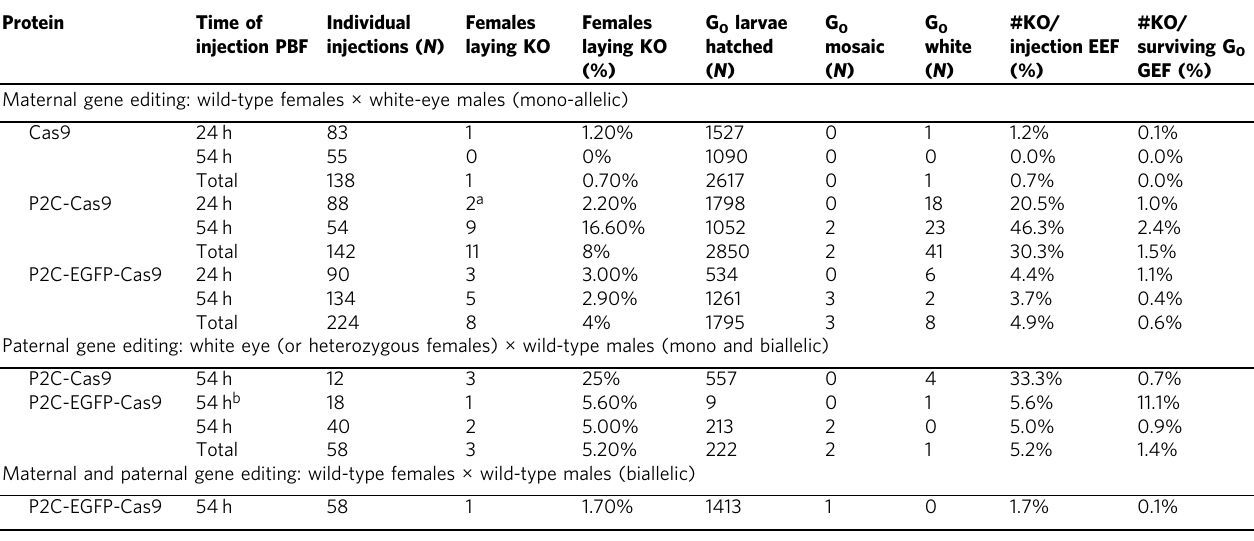
Table 1 ReMOT Control gene editing using optimized concentrations for EER and the RNPs Cas9, P2C-Cas9 and P2C-EGFP- Cas9s Protein Time of Individual Females injection PBF injections ( N ) laying